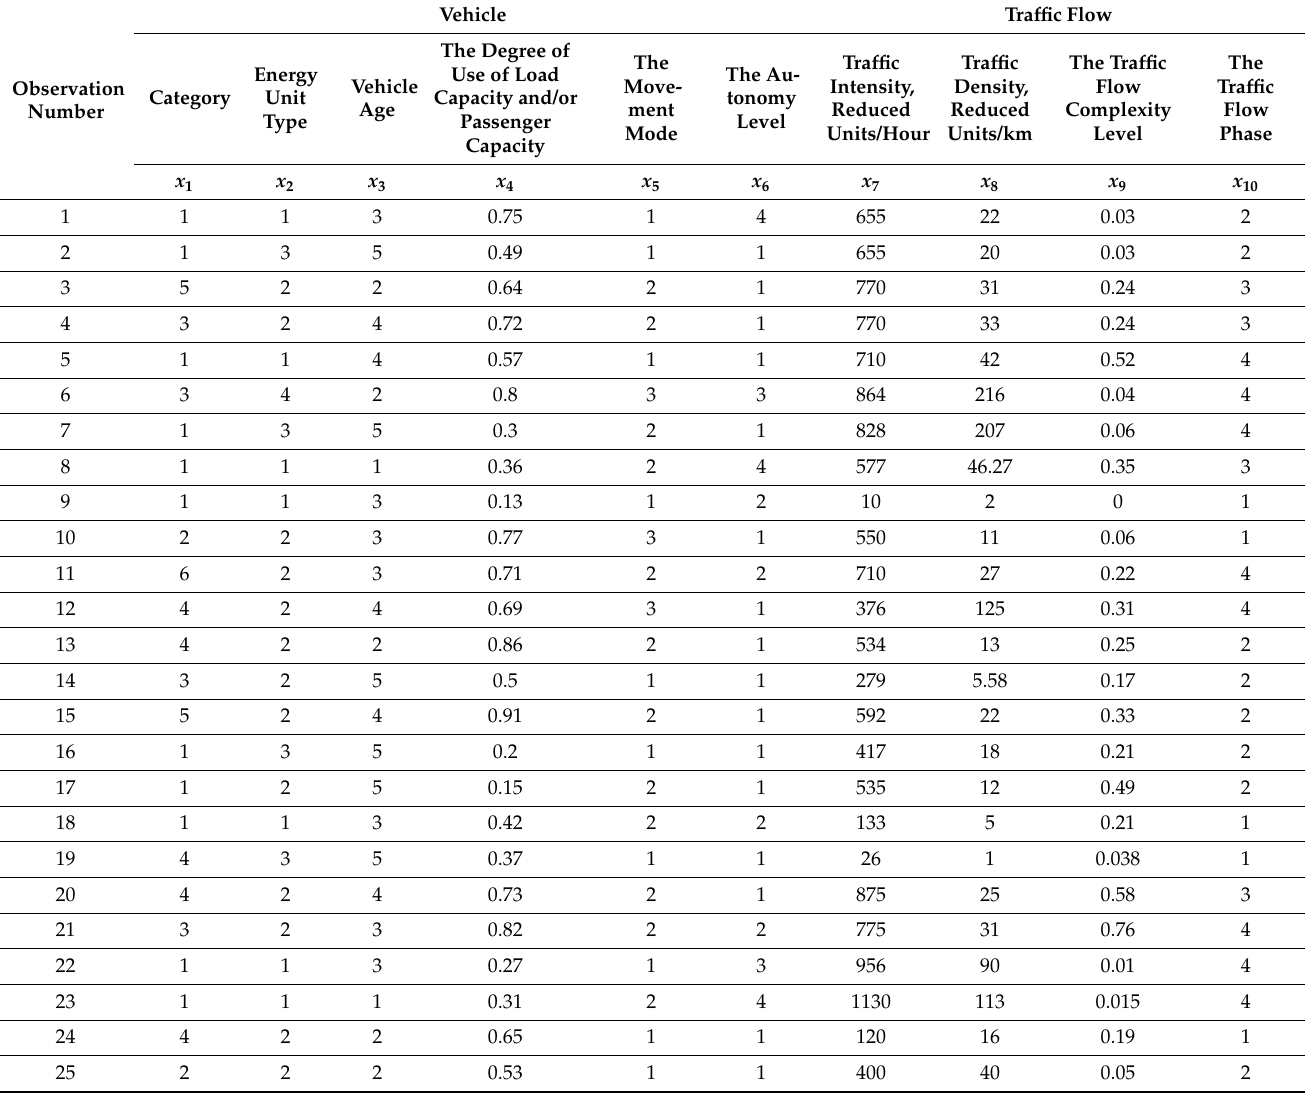
Table 4. Observation results for the functional elements “Vehicle” and “Traffic